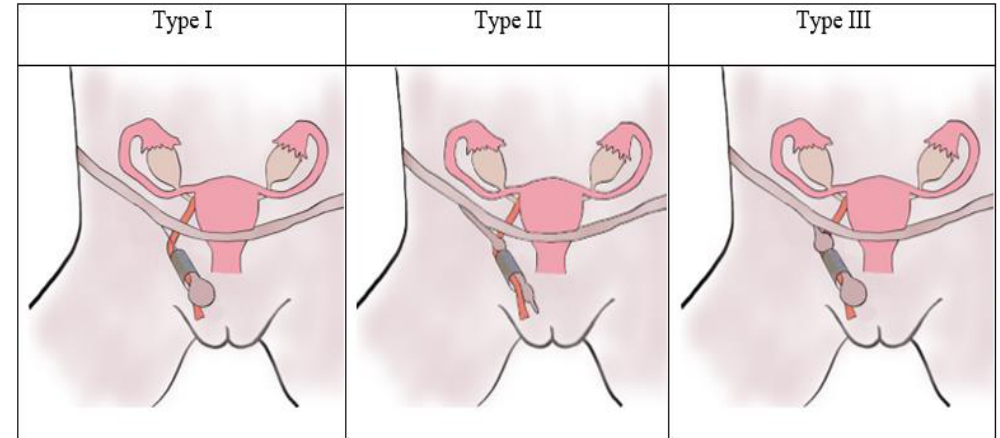
Figure 5. Schematic overview of the different types of cysts of the canal of Nuck as classified by Counseller and Black.